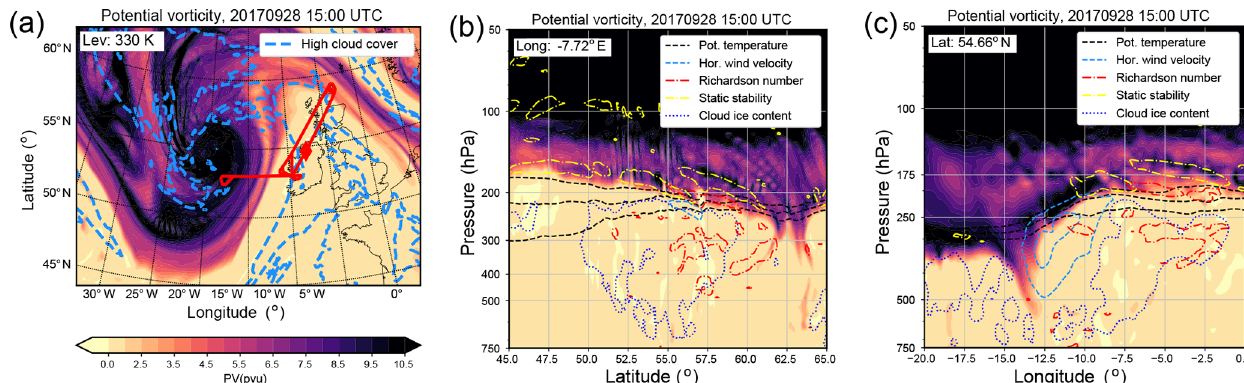
Figure 1. Synoptic situation during WISE RF7 over the western North Atlantic at 15:00UTC on 28 September 2017. (a) Potential vorticity on the isentropic surface of 330K with high cloud cover (isoline showing a value of 0.9). (b) Meridional cross section of potential vorticity along − 7 . 72 ◦ E longitude and (c) zonal cross section along 54.66 ◦ N latitude. The cross sections also show isolines of potential temperature (black dashed; 330, 335, 340K), of horizontal wind velocity (light blue dashed; 45, 55ms − 1 ), the Richardson number (red dashed–dotted; 1), static stability (yellow dashed–dotted; 5 . 5 × 10 − 4 s − 2 ), and cloud ice content (blue dotted; 5 × 10 − 6 kgkg − 1 ). The cross sections are along the meridian and the circle of latitude of the red diamond shown in panel (a) . This point also marks the location where the picture in Fig. 2b is taken.